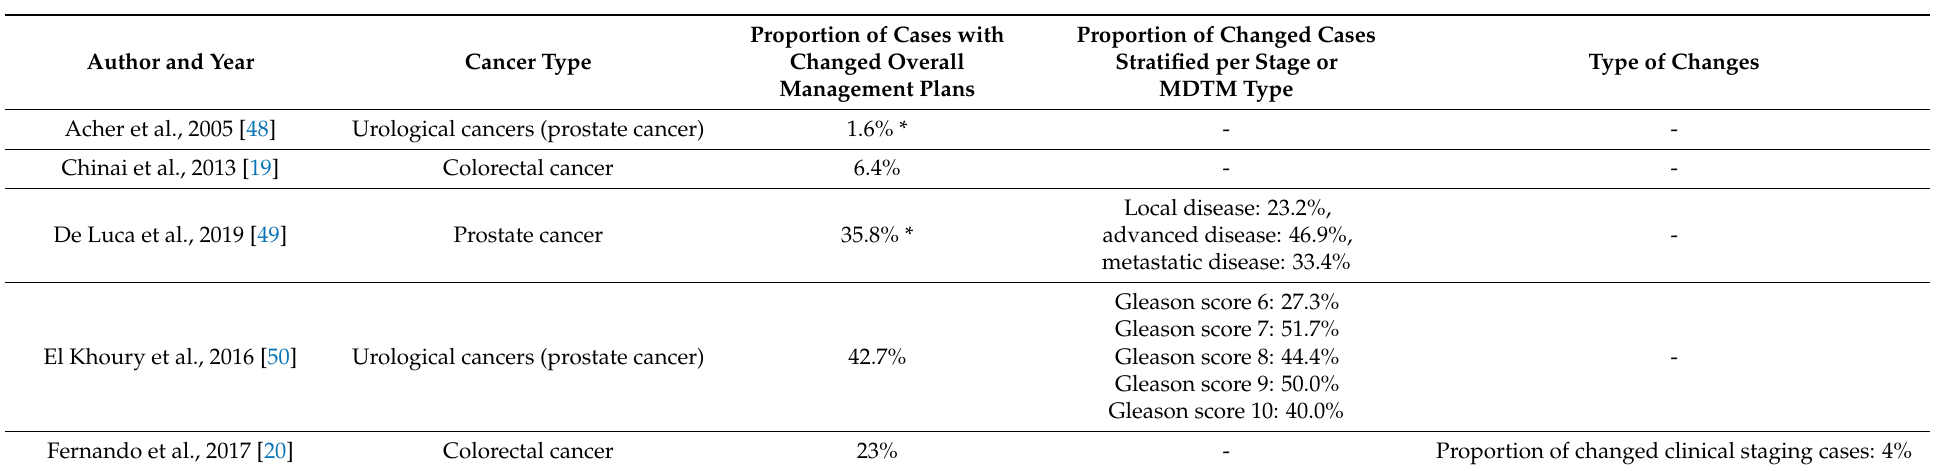
Table 3. Results for changes in management